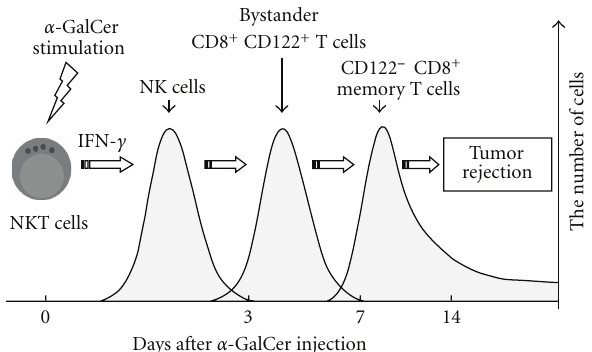
Figure 1: Sequential activation of liver lymphocytes and antitumor immunity by α